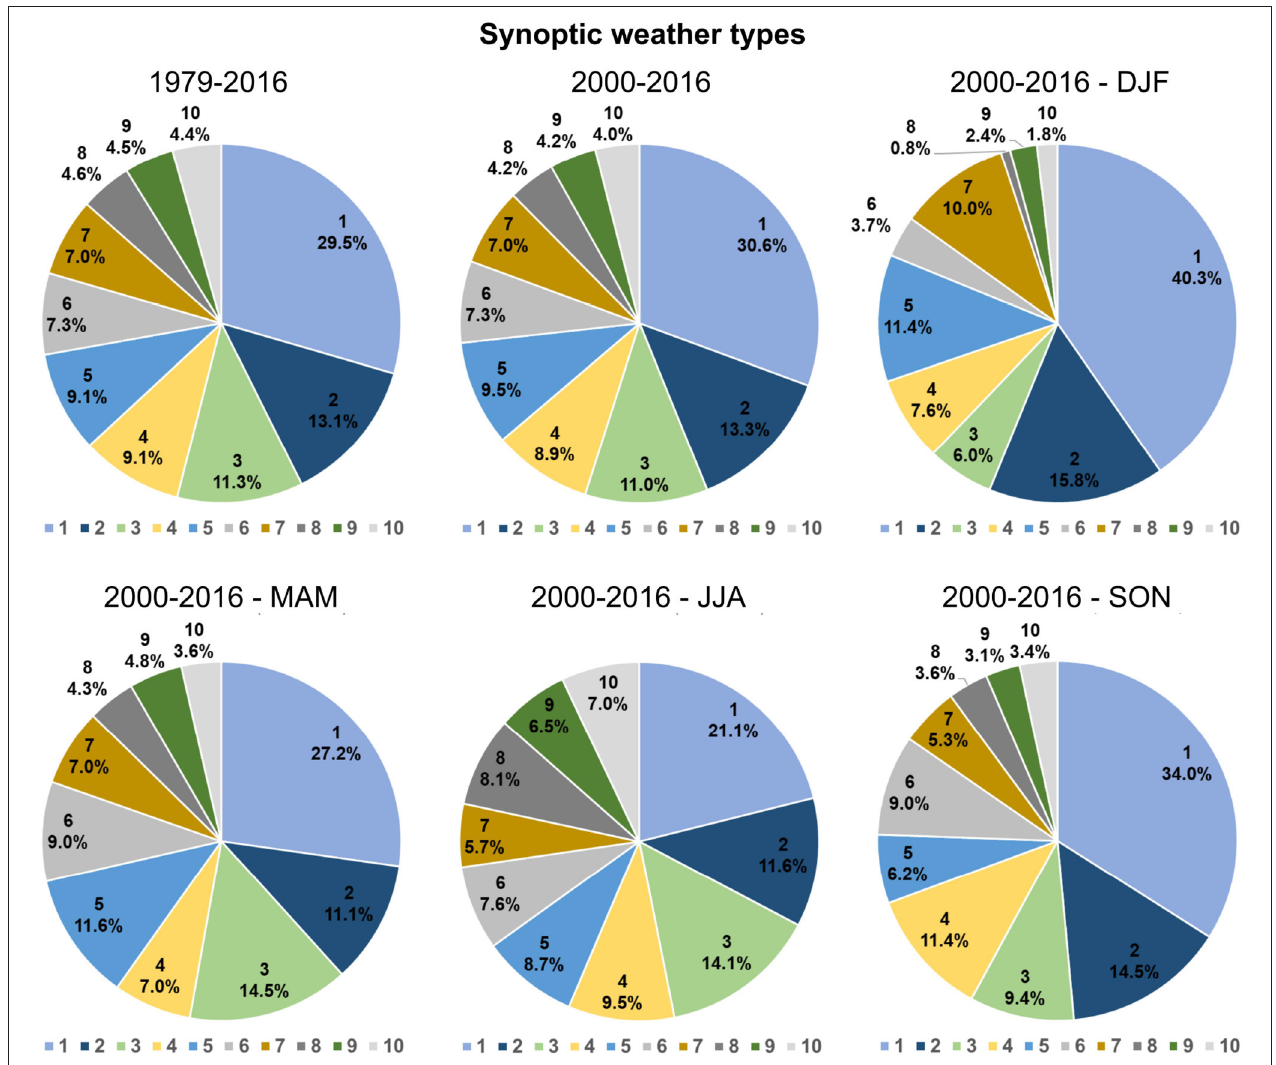
FIGURE 8 | Frequencies of synoptic weather types averaged between 1979 and 2016, 2000 and 2016 and for summer (DJF), fall (MAM), winter (JJA) and spring (SON) between 2000 and 2016.